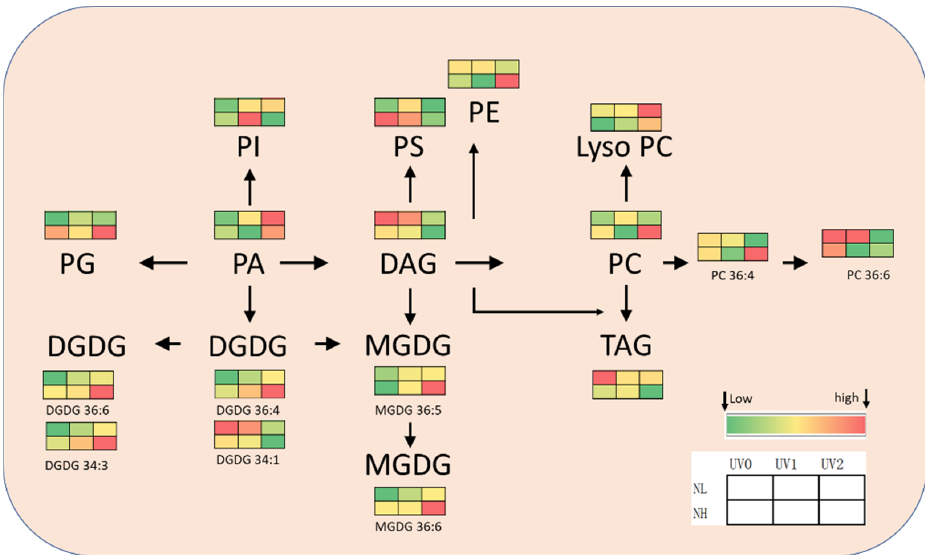
Figure 6. Diagram of simple pathways of lipid metabolism in plants. The square shows the changes of lipid content in tea leaves under different treatments, where green indicates low content and red indicates high content.